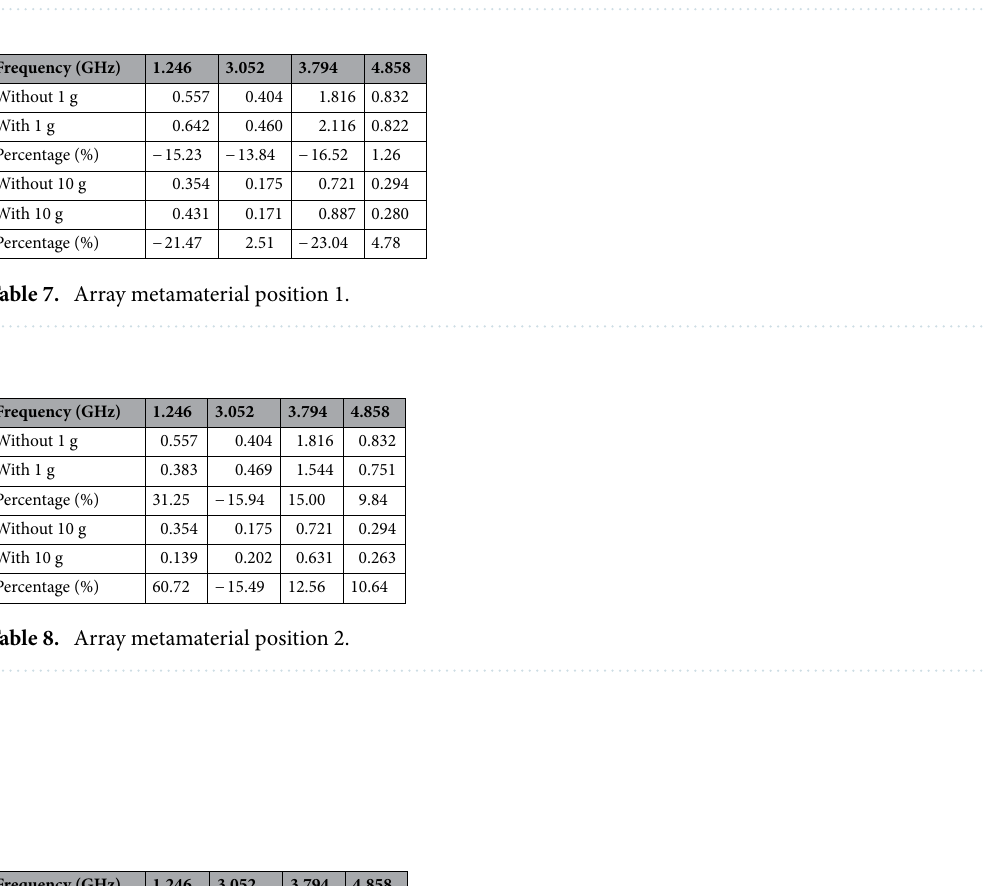
Figure 8. Placement of SM design in mobile phone: ( a ) position 1, ( b ) position 2, ( c ) position 3, ( d ) position 4.